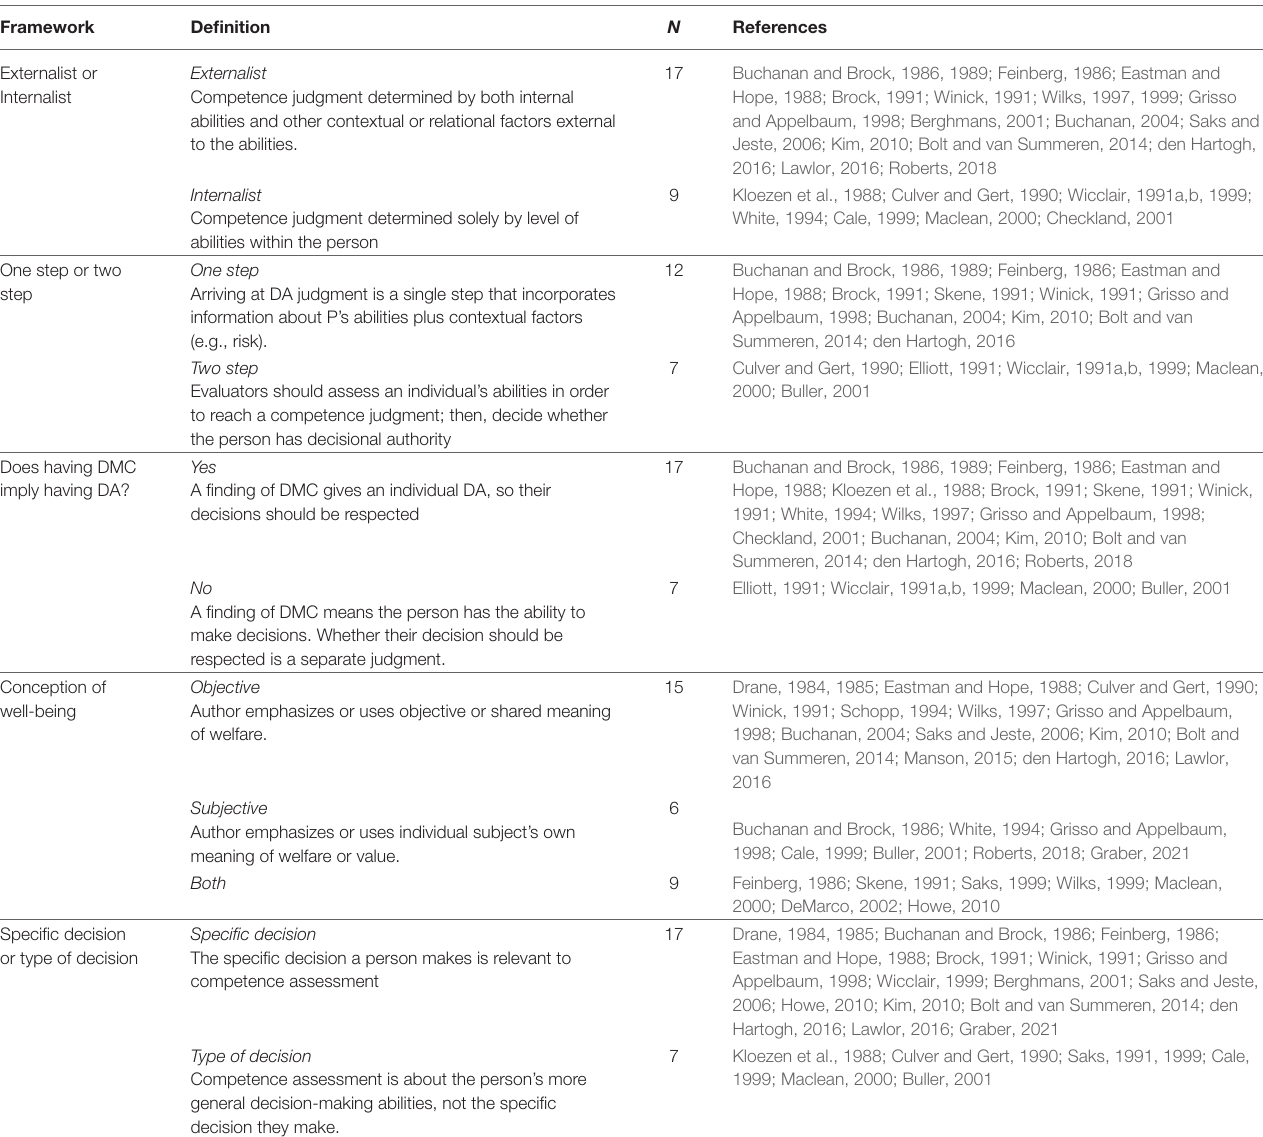
TABLE 5 | Frameworks